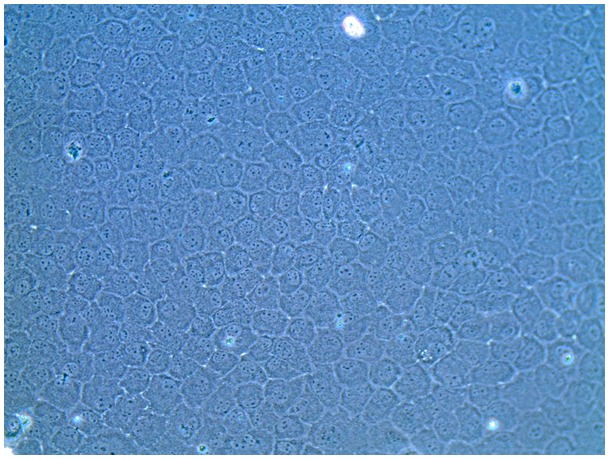
Micrograph showing the hexagonal morphology of a confluent layer of corneal endothelial cells (CECs) grown in DMEM + F12 medium supplemented with 5% heat-treated platelet releasate (HPR; magnification 200x).